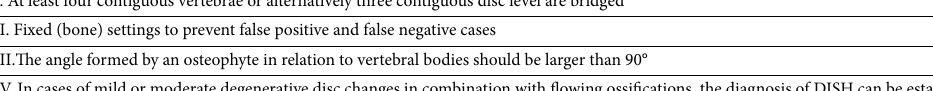
Table 1. Modified Resnick and Niwayama Criteria for Diagnosis of DISH based on CT by Oudkerk et al. 17 . DISH diffuse idiopathic skeletal hyperostosis, CT computed